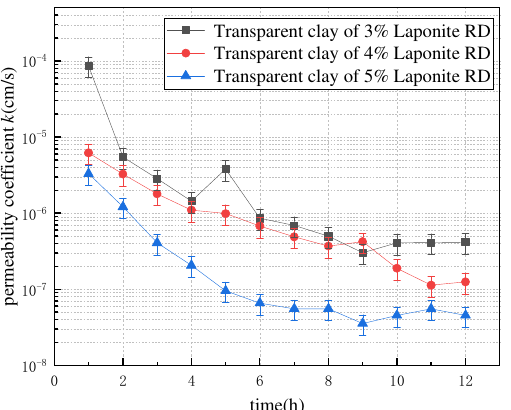
Figure 4. Folding line graph of osmotic coefficient with time for three groups of specimens at a 20-kPa osmotic pressure difference.